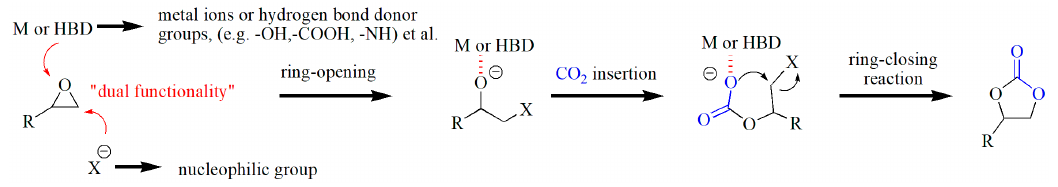
Scheme 1. Schematic representation of the possible reaction